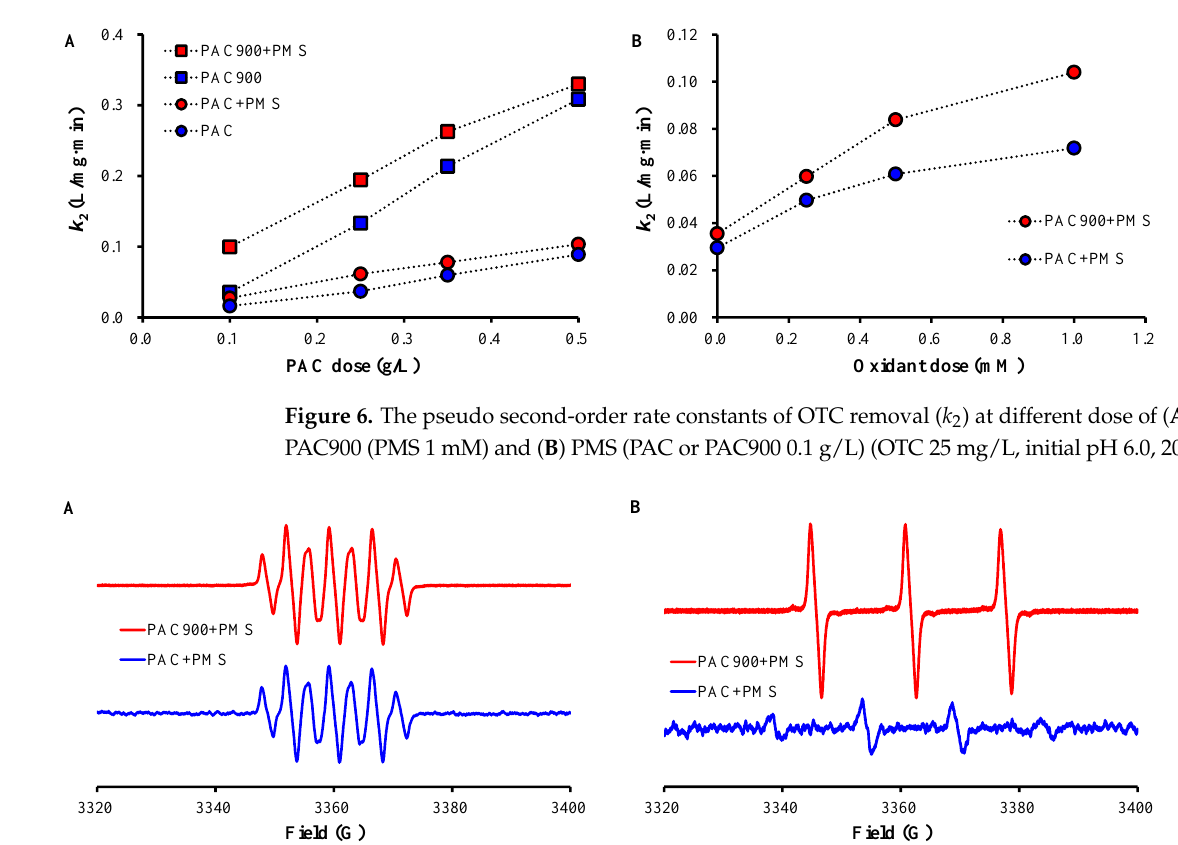
Figure 7. EPR spectra of PAC and PAC900 using ( A ) DMPO and ( B ) TMPO (PAC 0.5 g/L, PMS 1 mM, DMPO, or TMPO 10 mM).